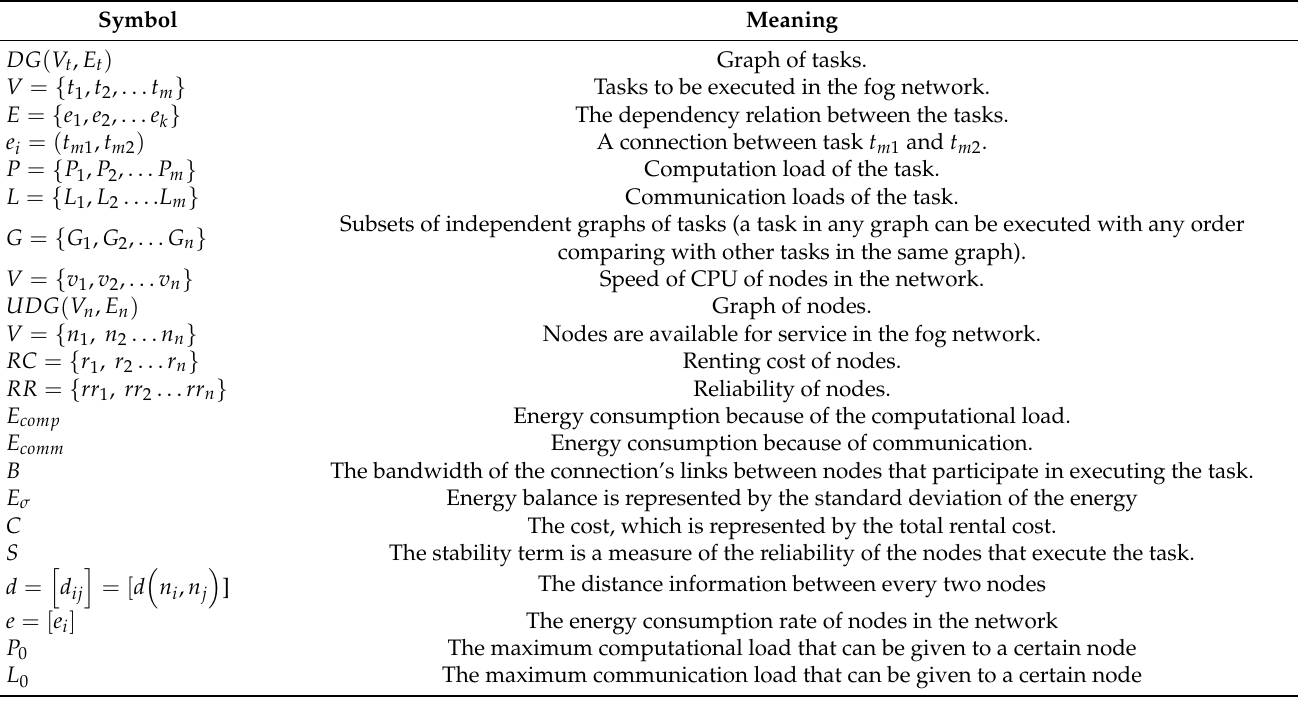
Table 2. Terms and symbols used for presenting the mathematical